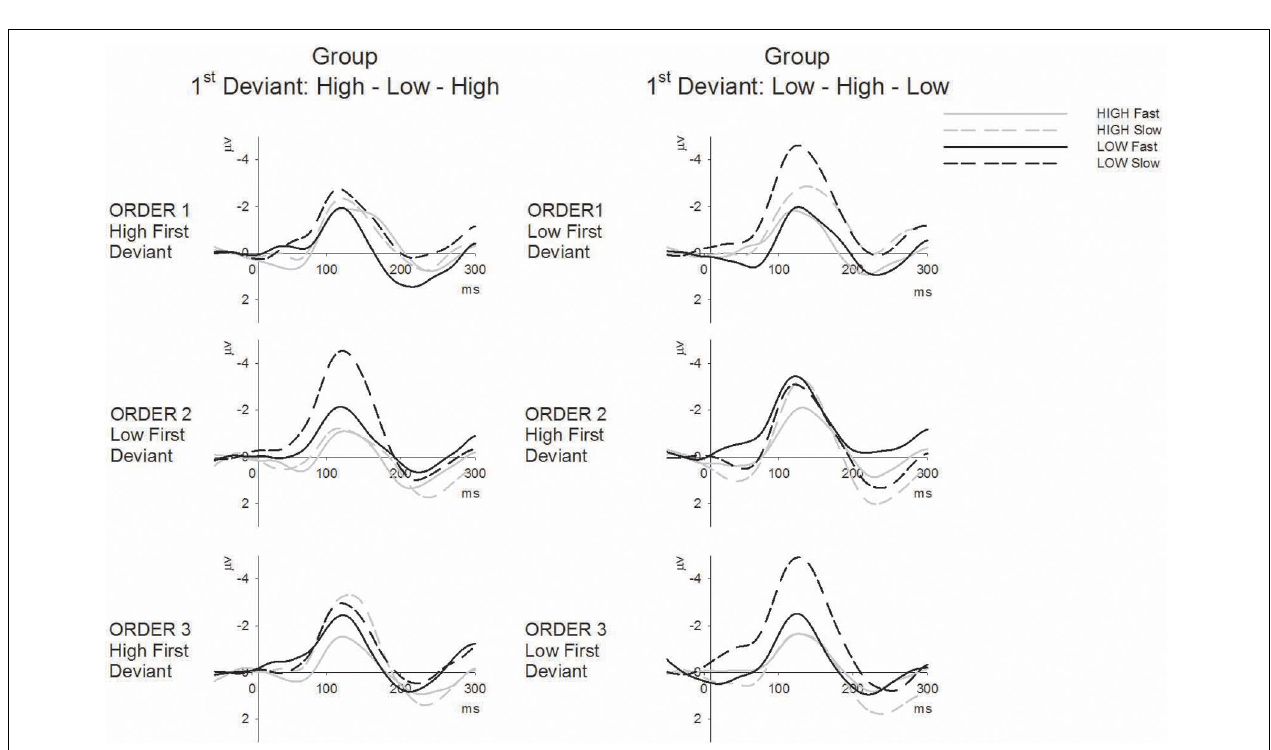
changes from the slow to the fast alternating sequences, separately for the three orders ( x -axes). Asterisks represent significant fast vs. slow sequence difference of the mean MMN amplitudes yielded by paired t -tests ( p < 0 . 05, at least). Error bars represent standard error of the mean.